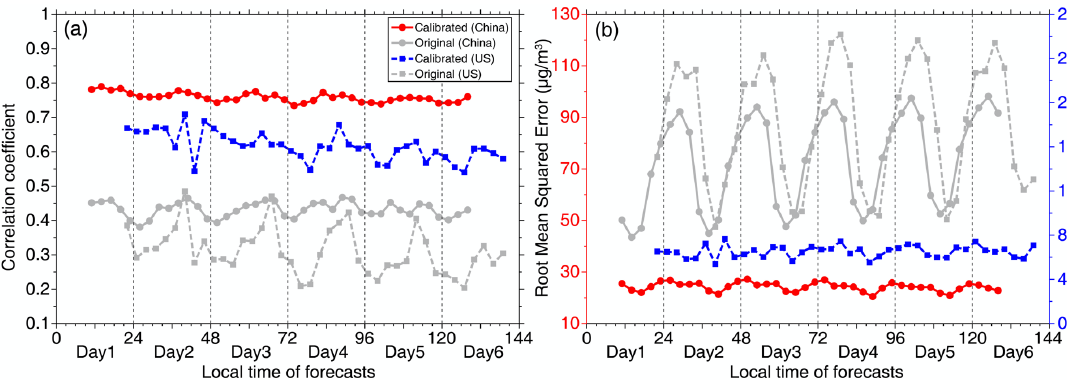
Figure 9. Comparison of the data accuracy of PM 2.5 forecasts before and after the data calibration. Note the correlation coe ffi cient ( a ) and RMSE ( b ) compared here were derived from the cross-validation dataset. The left axis in Figure 9b (red) refers to data values of RMSE for PM 2.5 forecasts in China while the right axis (blue) is for that of US.